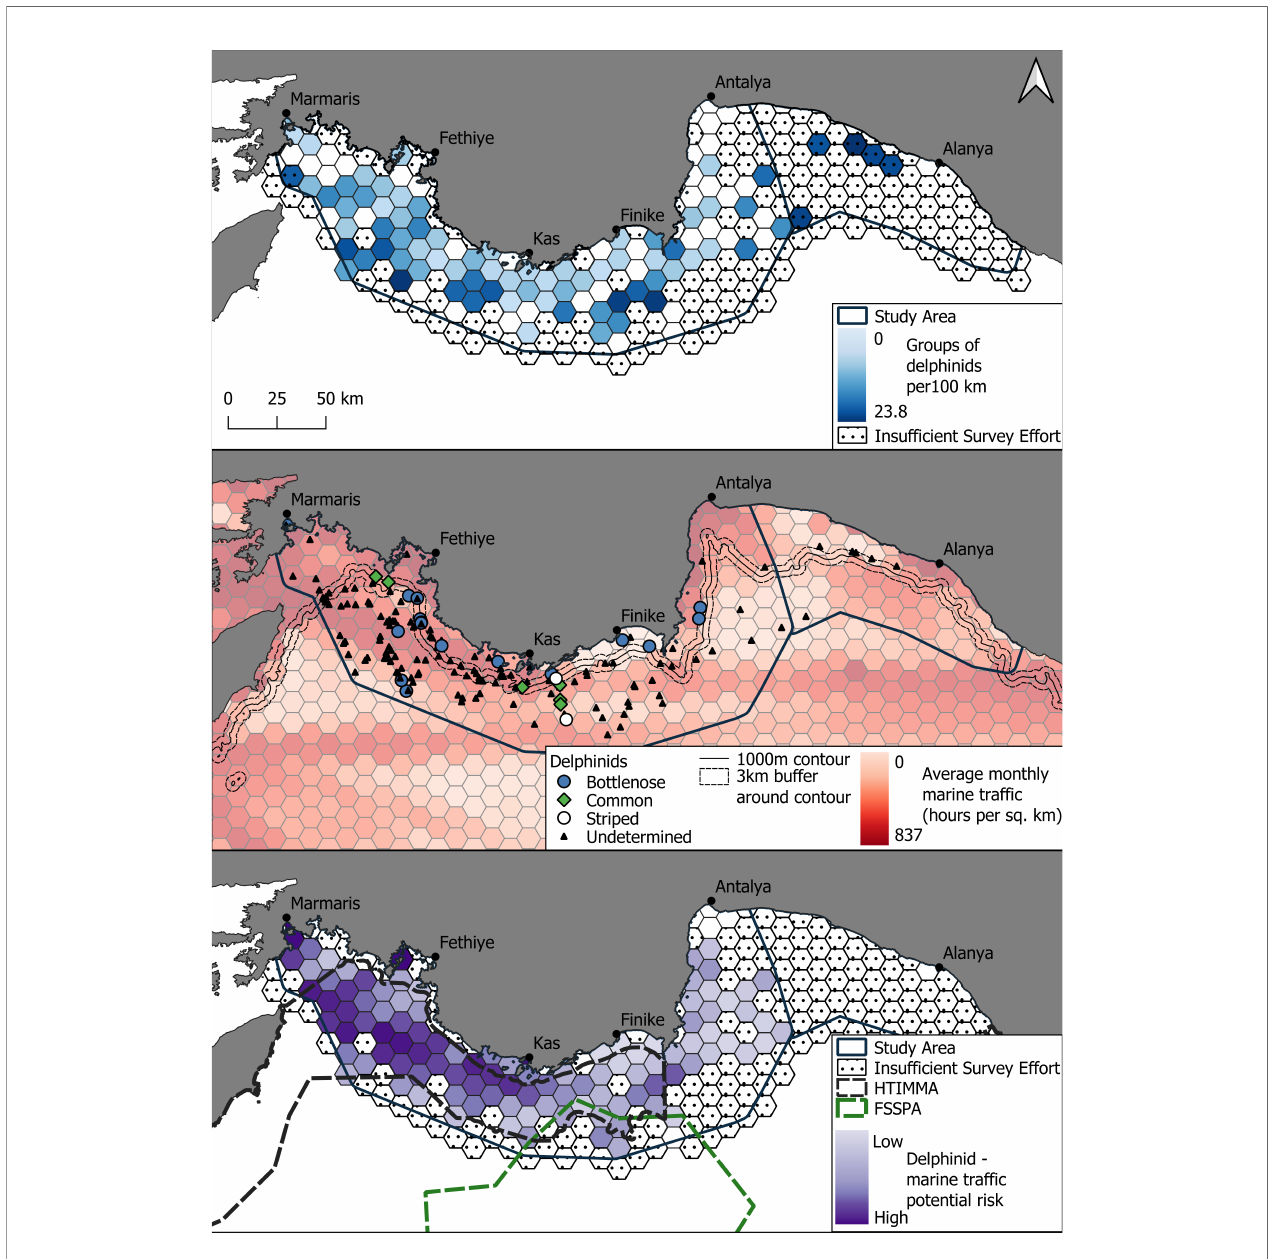
FIGURE 3 | (Upper) Groups of delphinids per 100 km in the Eastern Mediterranean Sea with darkening blue representing an increased number of delphinid groups. (Middle) The distribution of different delphinid species with bottlenose, striped, common and undetermined groups of delphinids denoted by blue circles, green diamonds, hollow circles and fi lled triangles respectively. Distribution is superimposed onto the average monthly marine traf fi c (hours per square kilometre) with darkening red signifying higher traf fi c. Marine vessel information used in this fi gure was made available by the EMODnet Human Activities project, www.emodnet- humanactivities.eu, funded by the European Commission Directorate General for Maritime Affairs and Fisheries. The 1000m contour is shown with a 3km buffer area around the contour. (Lower) Potential risk areas where the presence of delphinids and marine traf fi c were both high during the study period. Darkening purple shows an increased potential for